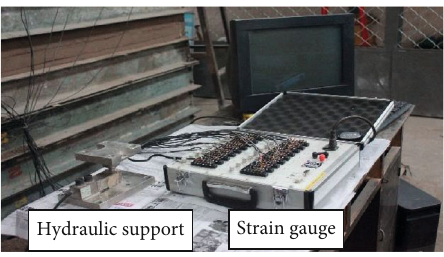
Figure 3: Testing